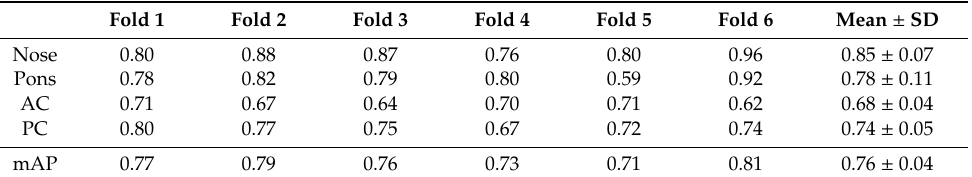
Table 1. Average precision (AP) and mean average precision (mAP) for the ROIs measuring 64 × 64 pixels.